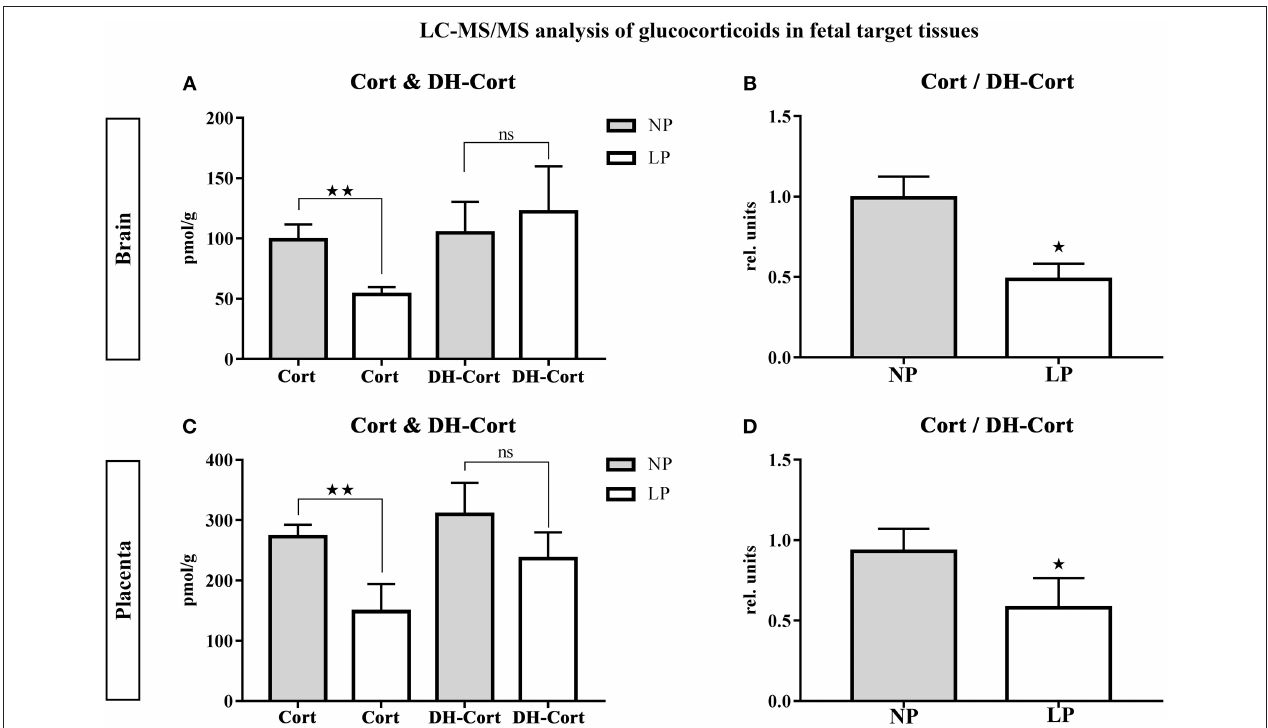
FIGURE 3 | LC-MS/MS analysis of local glucocorticoid levels in fetal target tissues. Results of fetal brain are shown in (A,B) , results of placenta are shown in (C,D) . (A) Differences of corticosterone (Cort) and 11-dehydrocorticosterone (DH-Cort) levels in fetal brains of NP ( n = 4) and LP ( n = 5) groups (pmol/g). (B) Differences of Cort/DH-Cort -ratio in fetal brain (relative units). (C) Differences of corticosterone (Cort) and 11-dehydrocorticosterone (DH-Cort) levels in placenta of NP ( n = 4) and LP ( n = 5) groups (pmol/g). (D) Differences of Cort/DH-Cort-ratio in placenta of NP ( n = 4) and LP ( n = 5) groups (relative units). Legend: Gray column represents NP group ( n = 4), white column represents LP ( n = 5) group, rel. units, relative units; ns, not significant; * p < 0.05, ** p < 0.01.